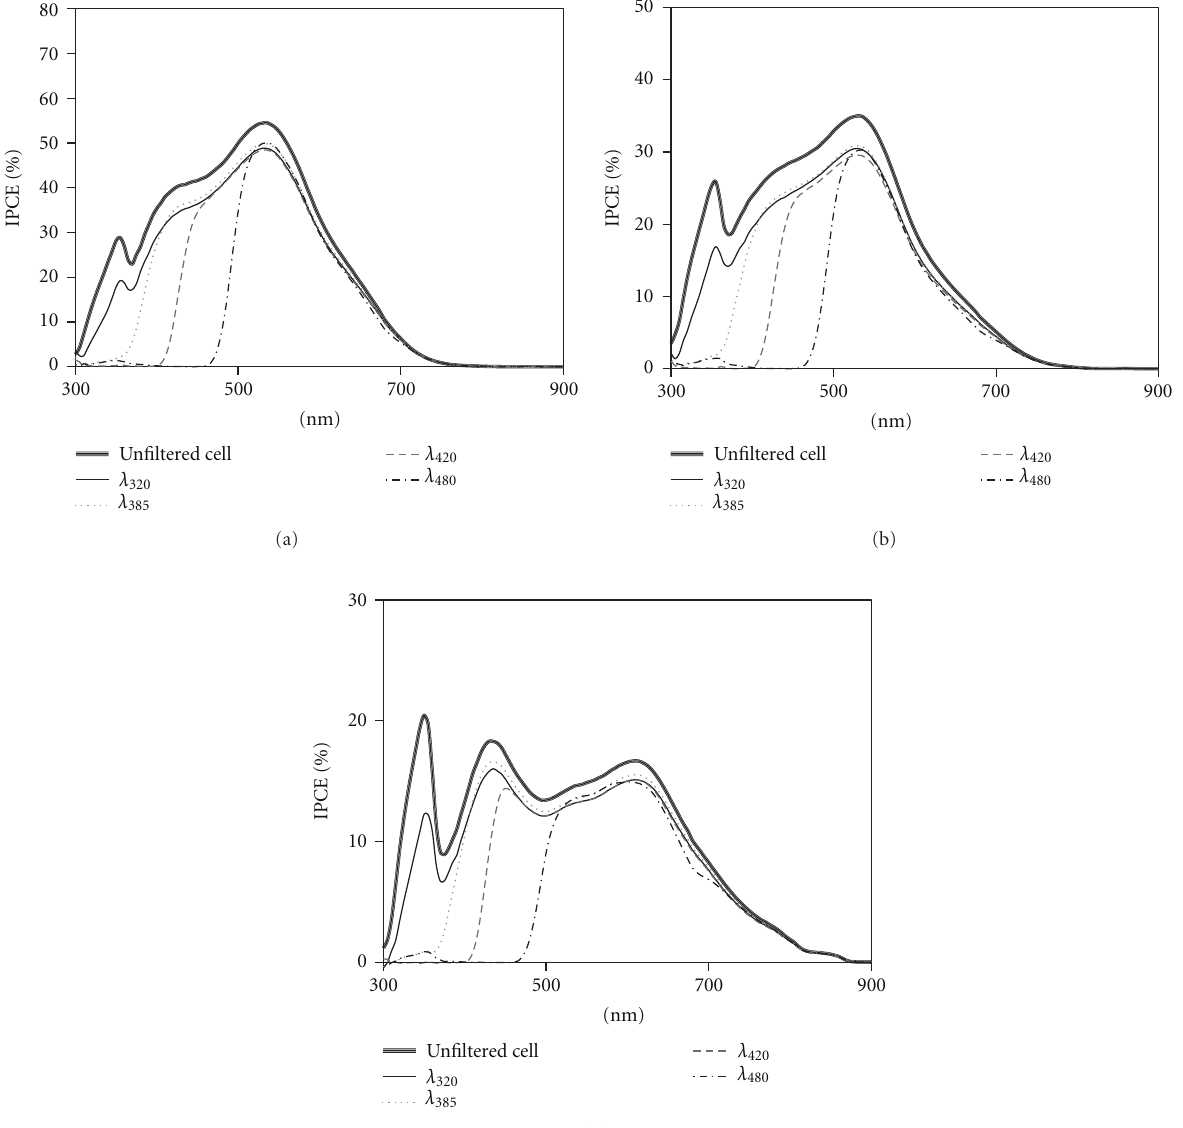
from antireflection and is as a result of the di ff erence in the refractive indices of the PET substrate and the UV absorbing PU